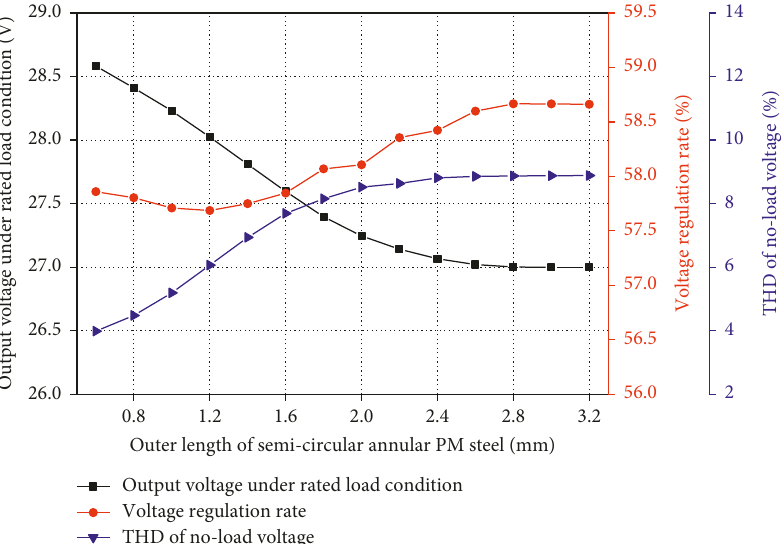
Figure 15: Variation curves of generator output performance with different outer lengths of semicircular annular PM